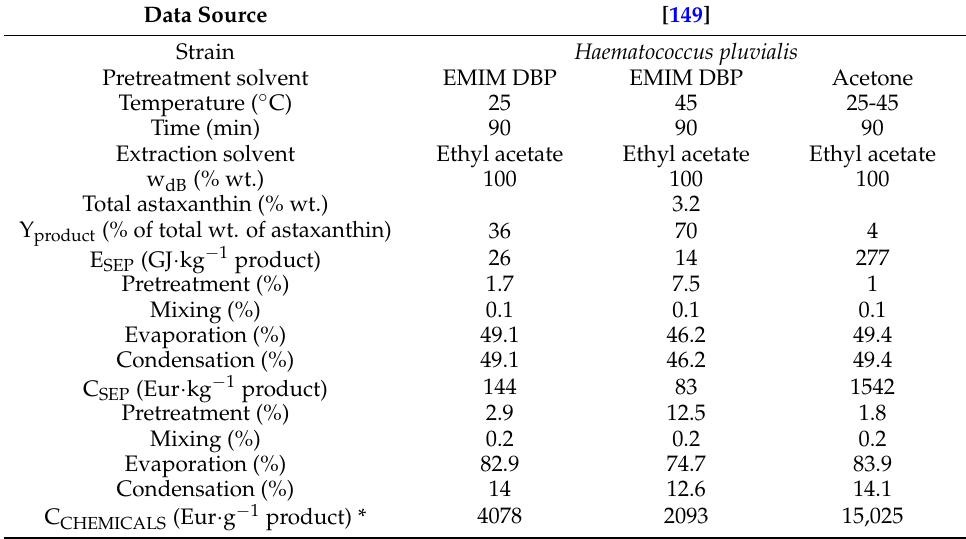
Table 6. Energy requirement, energy and production costs for astaxanthin